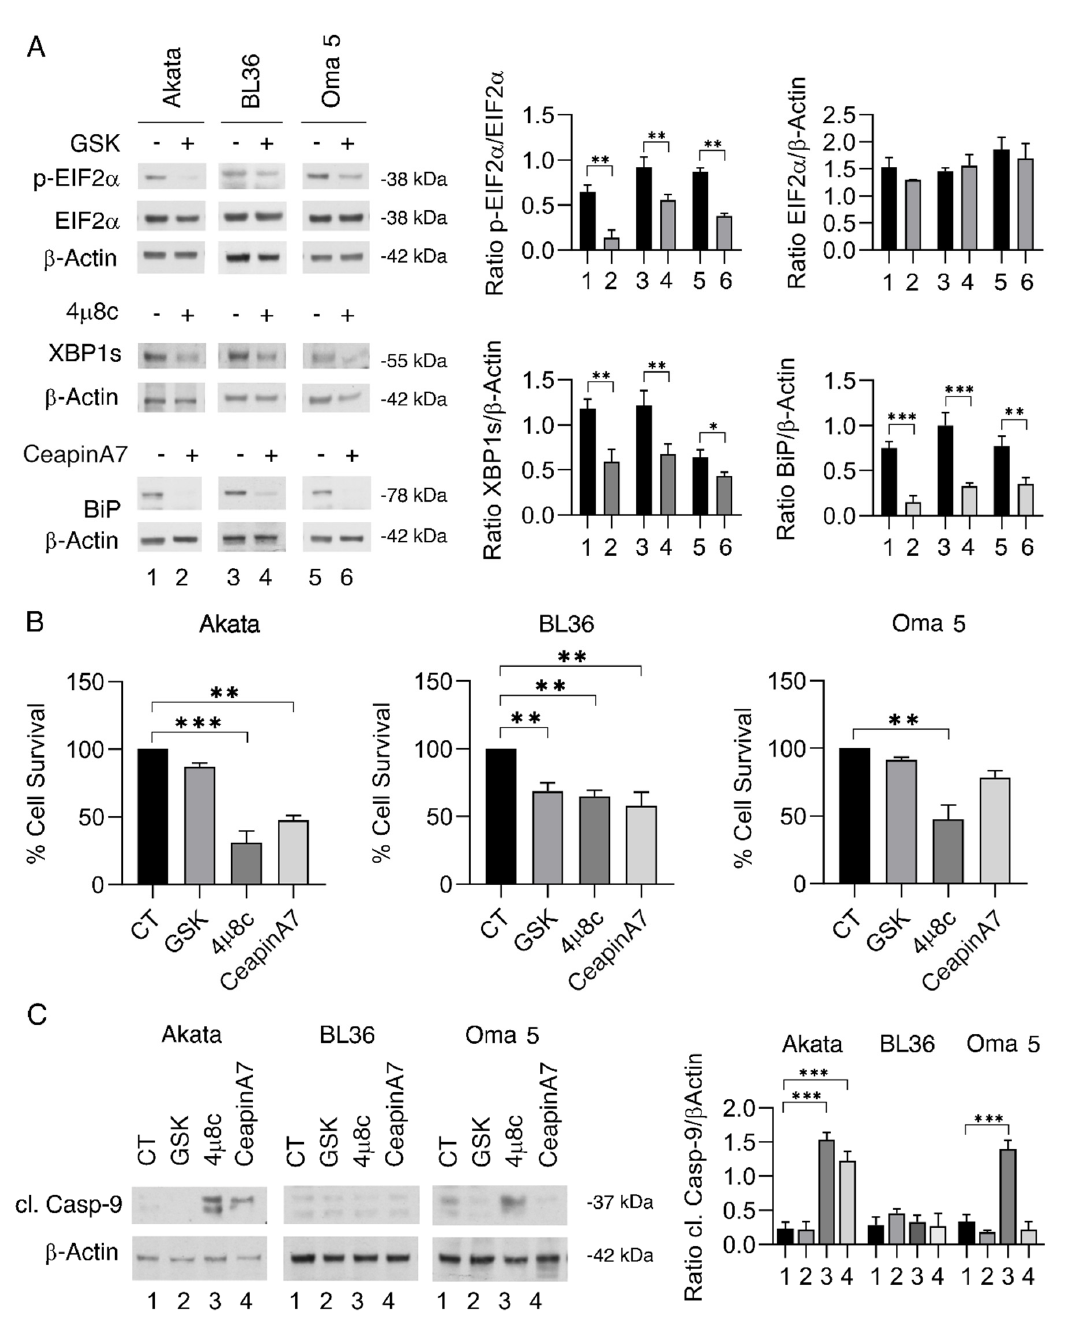
Figure 1. Effects of PERK, IRE1-alpha, and ATF6 sensors inhibition in BL cells. Akata, BL36, and Oma 5 cells were treated with GSK2606414 (GSK) (0,5 μ M), 4 μ 8C (15 μ M), or CeapinA7 (12 μ M). The untreated cells were used as control (CT). ( A ) Protein expression levels of p-EIF2 α , EIF2 α , XBP1s, and BiP were evaluated by Western blot analysis. β -Actin was used as loading control. The histograms represent the densitometric analysis of the ratio of specific protein and the appropriate control of three different experiments. The data are shown as the mean plus S.D. ( B ) Cell viability was measured by a Trypan Blue exclusion assay, and the histograms represent the mean plus S.D. of live cells as percent of untreated control cells of three different experiments. ( C ) Protein expression level of cleaved Caspase-9 (cl. Casp-9) was evaluated by Western blot analysis. β -Actin was used as loading control. The histograms represent the densitometric analysis of the ratio of cl. Casp9/ β -Actin of three different experiments. Data are represented as the mean plus S.D. p value: * p < 0.05; ** p < 0.001; *** p < 0.0001.